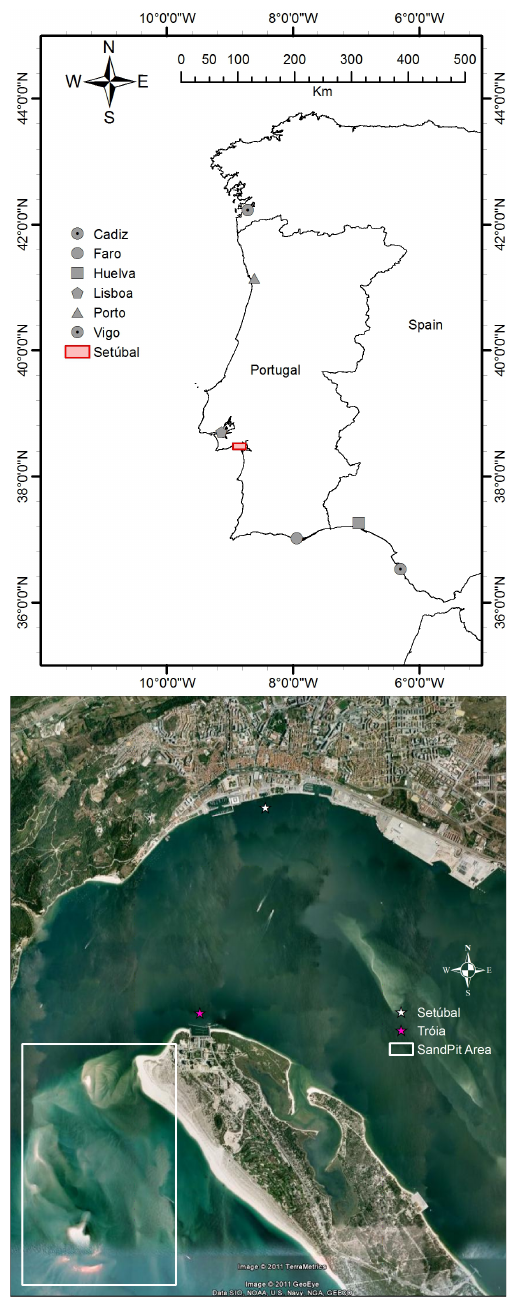
Fig. 1. Location of the test